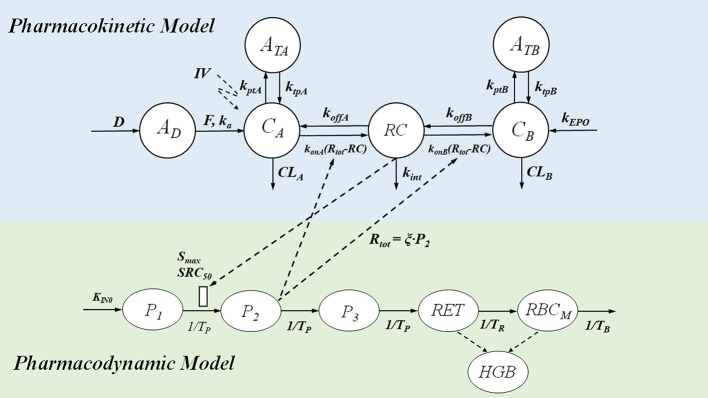
Mechanism-based PK-PD model of ESAs. The upper panel of the flow schematic is based on the TMDD model to describe the PK process. D and AD represent the duration of the zero-order input and absorption compartment for the SC route, respectively. F is the bioavailability, and ka is the first-order absorption rate constant. C
A, C
B, and RC represent the concentration of free ESAs, endogenous EPO (eEPO), and the EPO-receptor complex, respectively. ATA and ATB are tissue compartments, k
tpA, k
tpB, k
ptA, and k
ptB are tissue distribution rate constants; k
onA, k
onB, k
offA, and k
offB represents second-order rate constants for forming RC and first-order dissociation rate constants of ESAs and eEPO; Rtot represents total receptor concentration; CLA and CLB are the first-order elimination rate constants; k
int is the first-order internalization and degradation rate constant; k
EPO represents the synthesis rate of eEPO. The PD model contains delay parameters, indicating the life span of various erythropoietic cells. P
1, P
2, and P
3 represent three different maturation-level erythroid precursor cell compartments; RET is reticulocytes, and RBCM is mature red blood cell; HGB represents hemoglobin. K
IN0 represents production process for P1 cells, S
max represents the maximal effect of RC on the proliferation of precursor cells, and SRC50 is the concentration of drug-receptor complex to induce half of S
max; T
P, T
R, T
B, mean residence time for precursor cell, reticulocytes, and mature red blood cell. PD effect of the expansion of precursor cell on Rtot mediates the PK process in return, and ξ is the factor of proportionality.